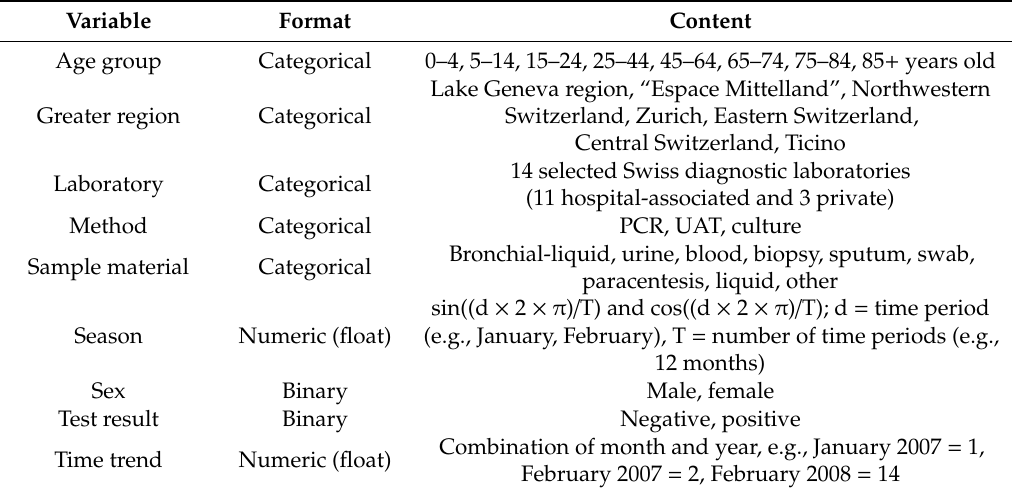
Table1. Overviewofthevariablesusedintheregressionmodelsonapositivetestresultfor Legionella spp. in Switzerland,